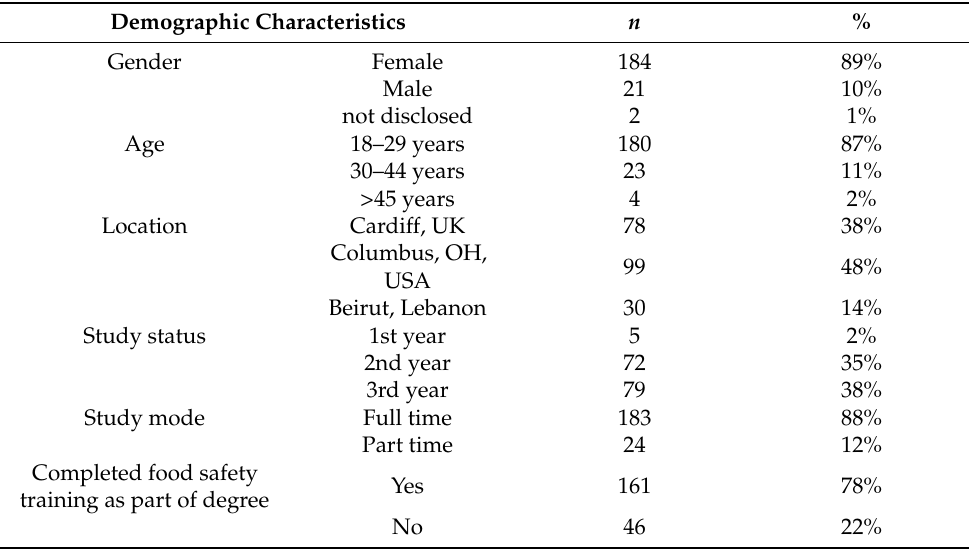
Table 1. Demographic profile of dietetic student participants ( n =